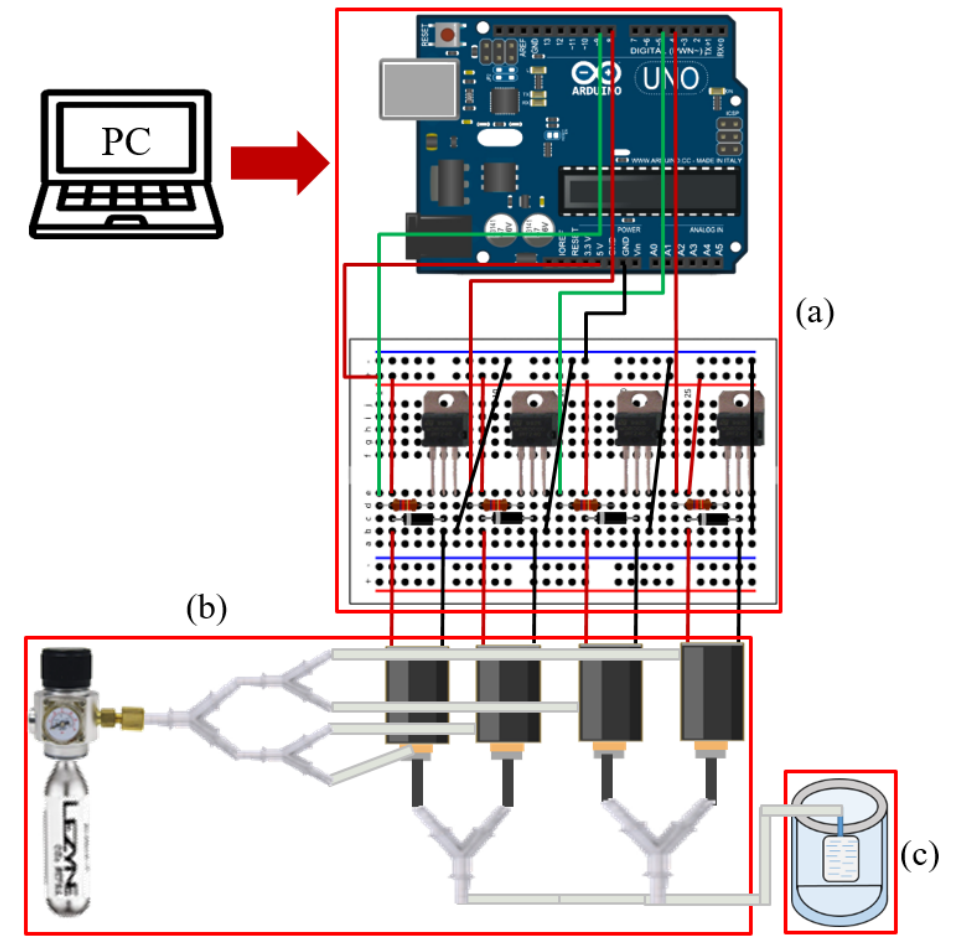
Figure 3. Hardware component for pneumatically controlling the actuator. ( a ) Electronics including the micro-controller, ( b ) the air cartridge with solenoid valves and silicone tube, and ( c ) the silicone- made pneumatic fingertip